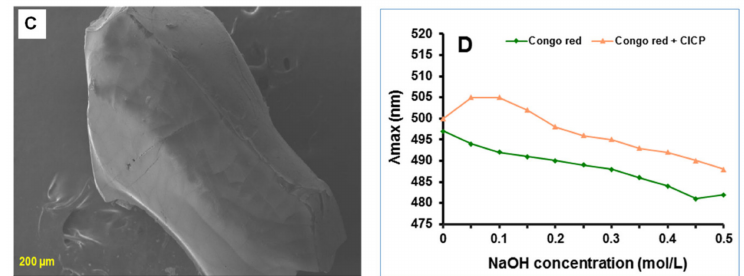
Figure 3. XRD pattern of CICP ( A ); SEM image of CICP ( B , C ); change in λ max of CICP at various NaOH concentrations ( D